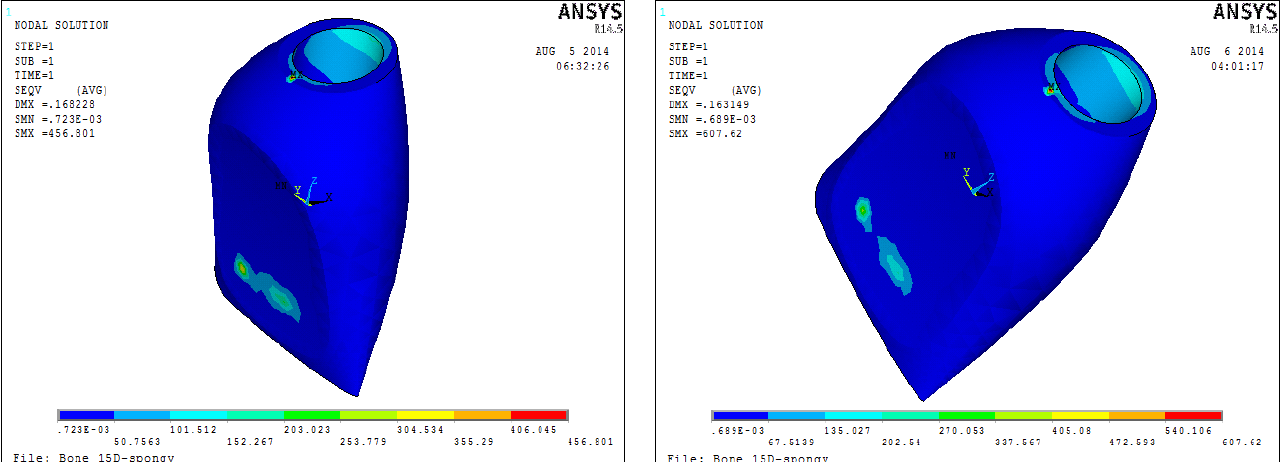
Fig.8: Von Mises stress distribution on different crown materials (a) IPS emax CAD, (b) Zirconia supported by 15° abutment.